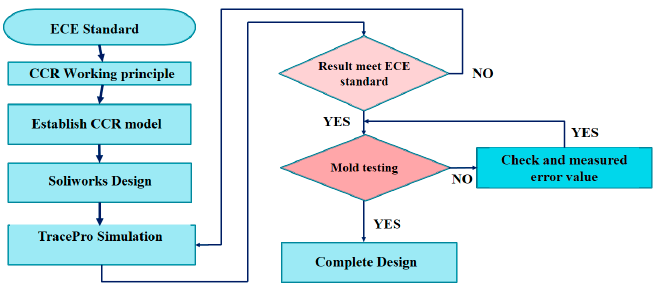
Figure 15. CCR design flow chart.